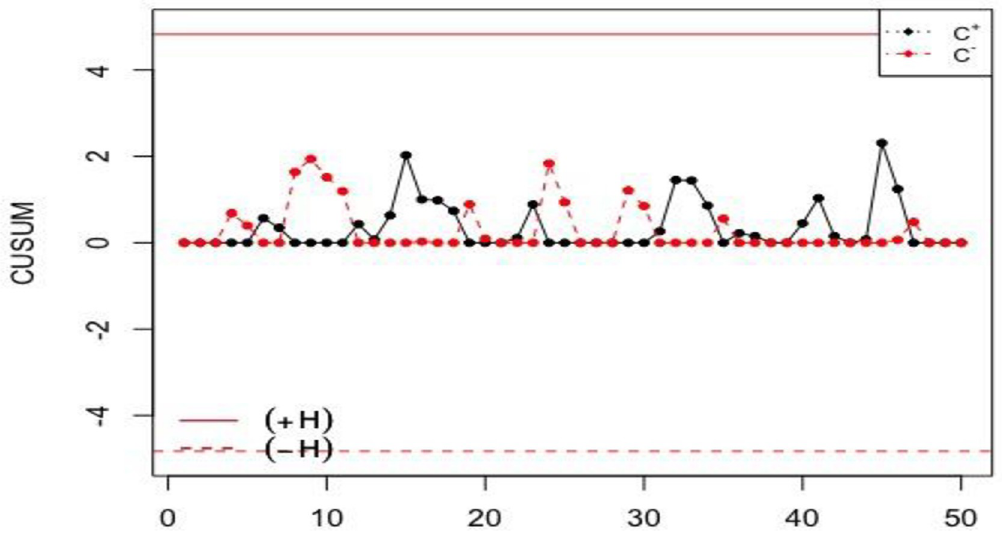
Fig 2. The classical CUSUM � X chart for simulated